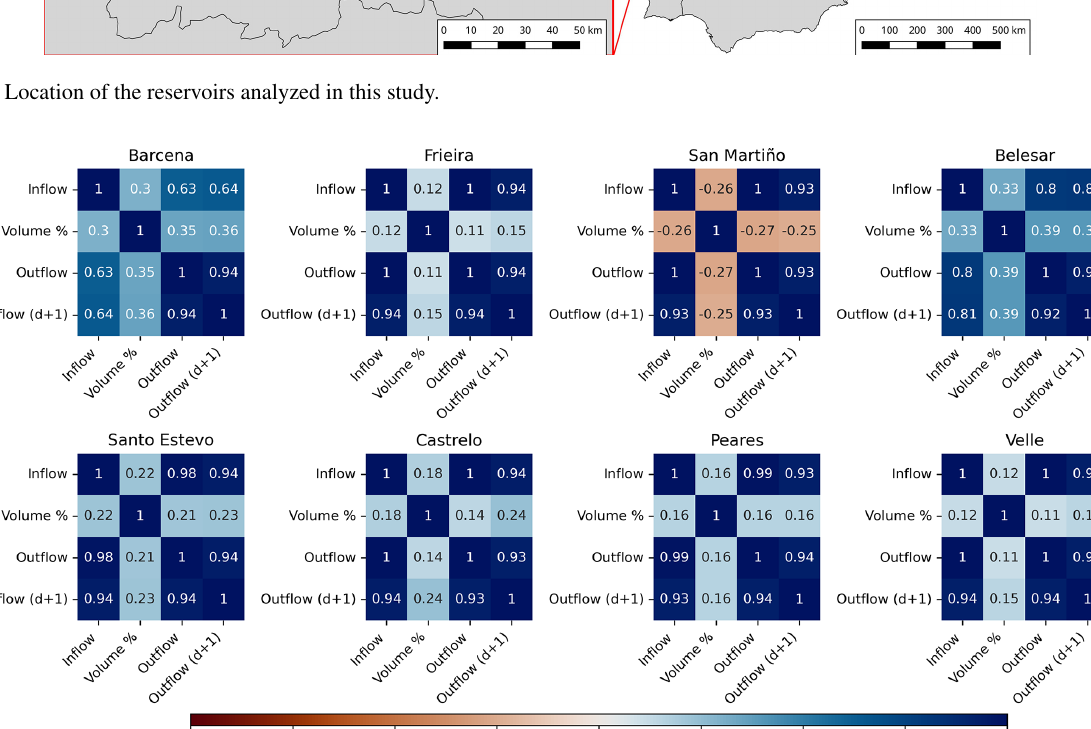
three coefficients ( c 0 , c 1 and c 2 ) were obtained from the lin- ear fitting depending on the measured filling level of the cor- responding